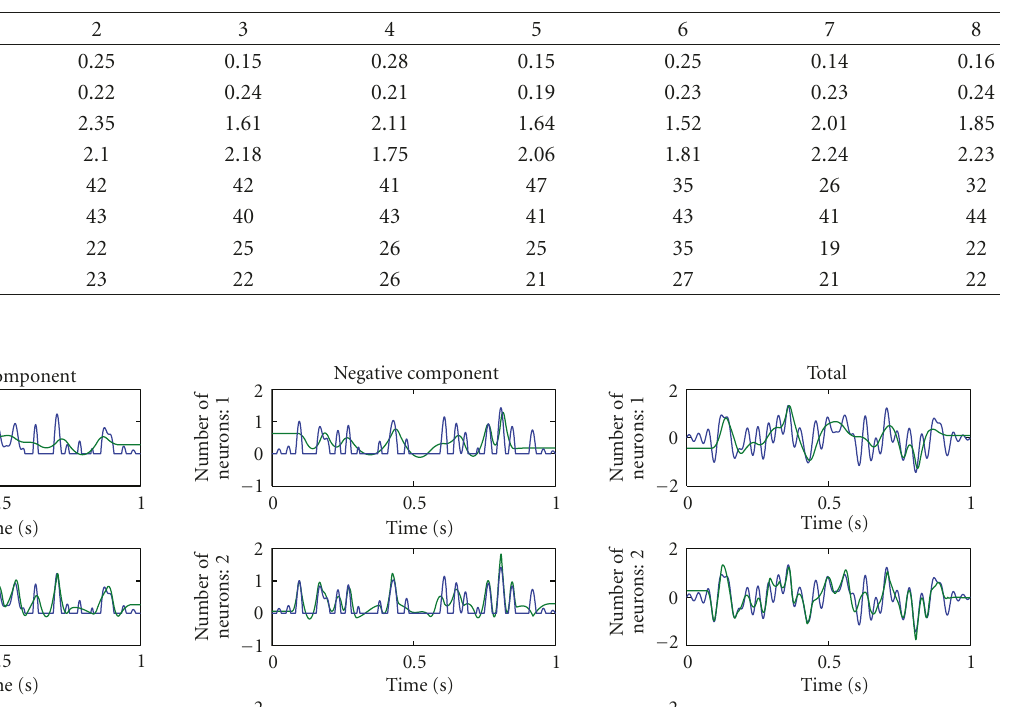
Table 2: Nominal values of the neuron parameters and the number of spikes fired. For each neuron we also had C i = δ i / 20 and σ i − = δ i − / 20 for all i = 1,2, ... ,8. σ i + +